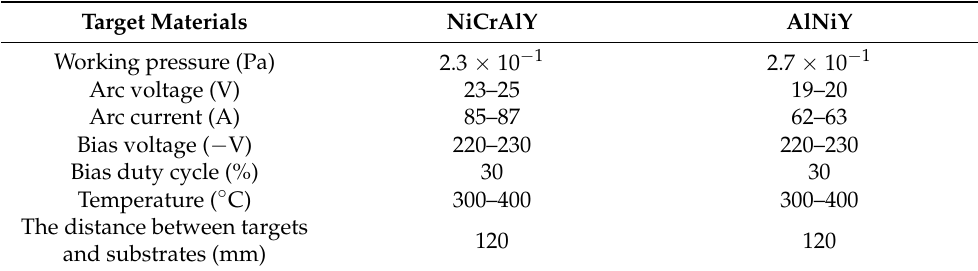
Table 1. Deposition parameters for the MCrAlY and AlSiY